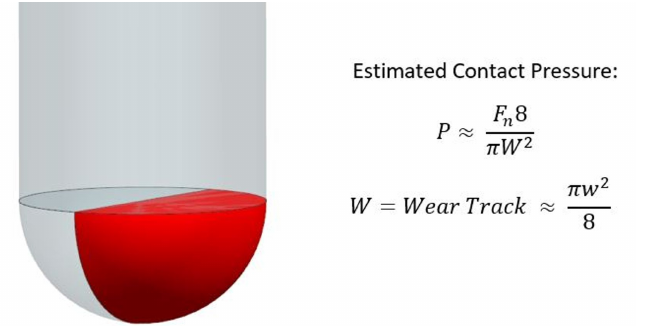
Figure 4. Geometric approximation for pressure proposed by Zemzemi [28] and implemented by Mondlein